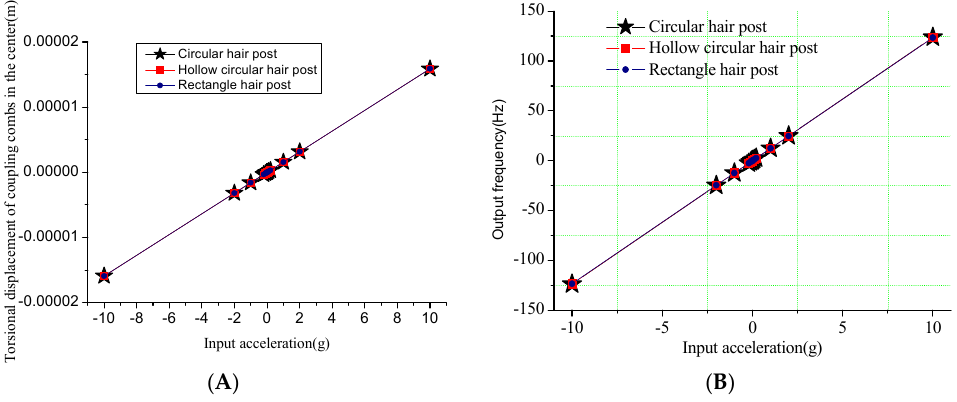
Figure 4. The signal outputs in the input of acceleration along x -axis. ( A ) Output torsional displacement versus acceleration; ( B ) Output frequency versus acceleration.